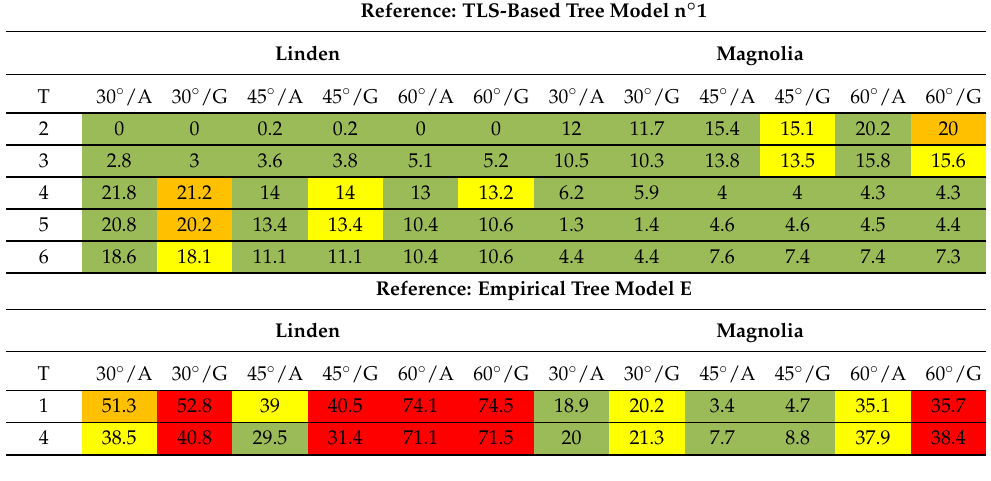
Table 5. Comparison of the normalized mean bias NB expressed in % between the two reference tree models and different geometric tree representations (first column: T stands for the number of the compared tree models) for 6 T c observations (SZA = 30/45/60 ◦ and BACKGROUND = A – asphalt / G – grass) and the two tree species. NB values are highlighted in green/yellow/orange/red for respectively good/acceptable/critical/unacceptable reflectance retrieval performances when compared to the according thresholds S NB